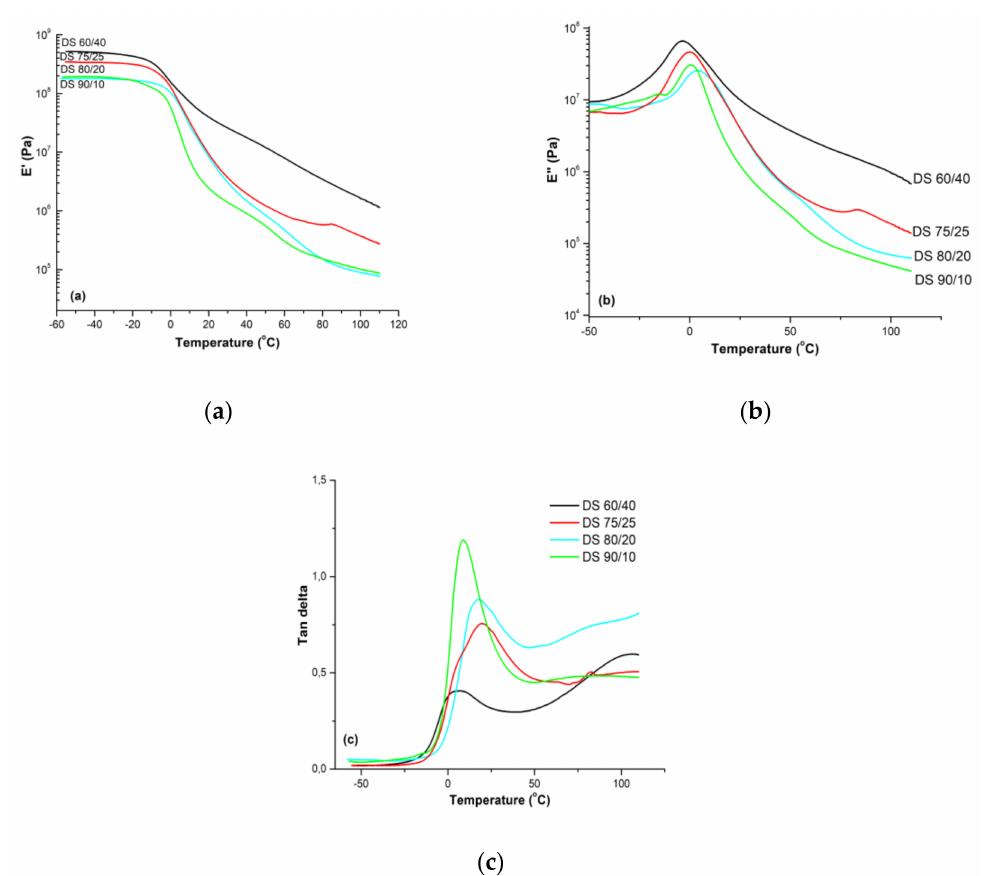
Figure 3. DMTA curves of the copolymer films function of temperature. ( a ) Storage modulus E (cid:48) ( b ) Loss modulus E (cid:48)(cid:48) ( c ) Tan δ